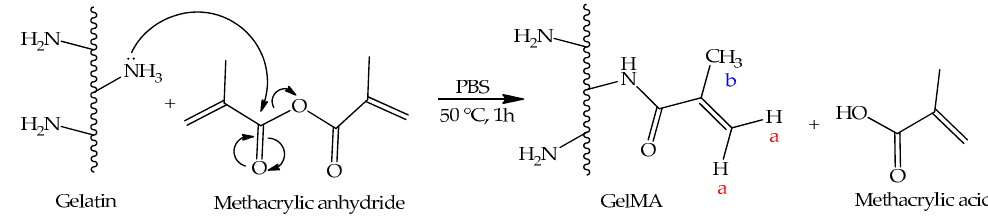
Figure 1. The reaction of gelatin functionalization with methacrylic anhydride.